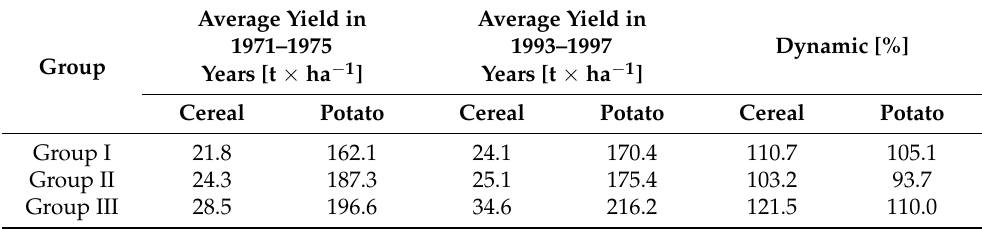
Table 2. The yield of selected crops and the dynamics of the yield depending on the distance from Bełchat ó w opencast mines (according to the data from the analyzed voivodships). Average Yield in Average Yield 1971–1975 Group